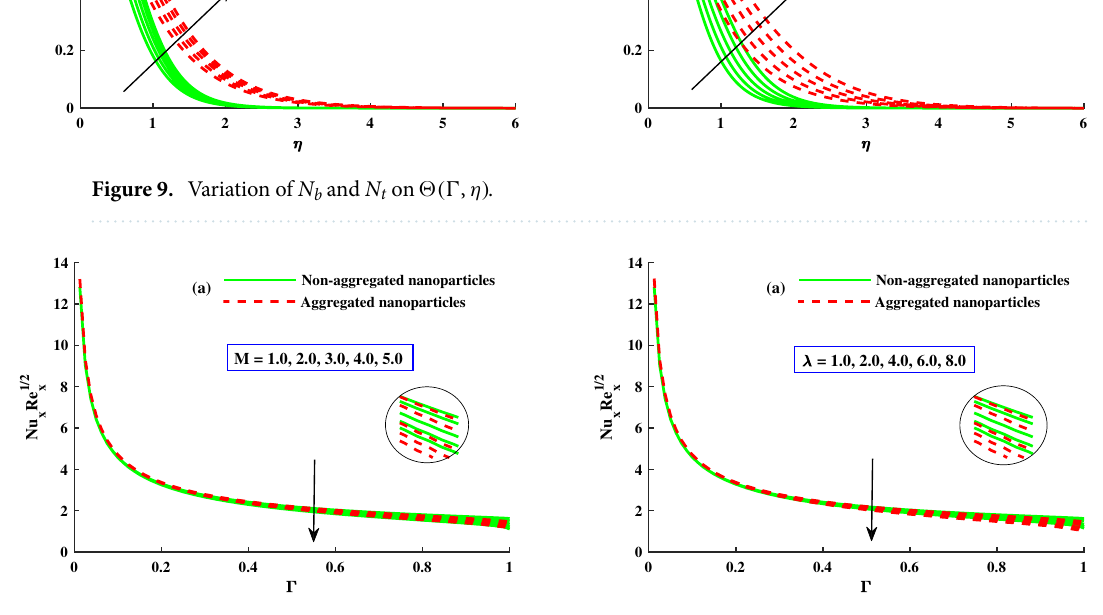
Figure 9. Variation of N b and N t on �(Ŵ , η) .